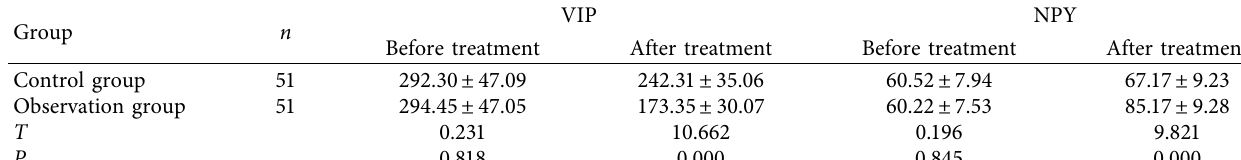
Table 2: Comparison of VIP and NPY levels in patients (pg/ml, ‾ x ± s ).